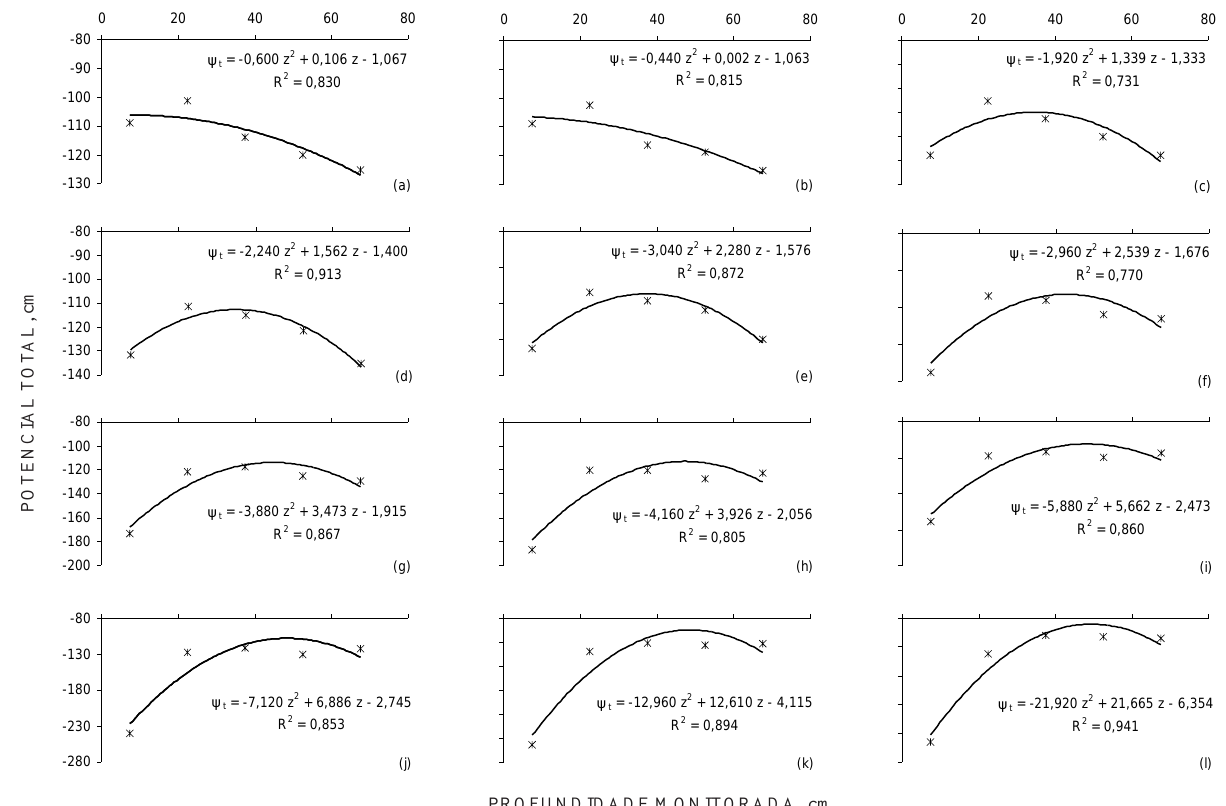
2. Potencial total ( yyyyy ) em função da profundidade ( z ) após 0 h (a), 17,9 h (b), 47,7 h (c), 65,1 h (d), t 88,5 h (e), 114,4 h (f), 137,8 h (g), 163,8 h (h), 186,8 h (i), 211,5 h (j), 282,6 h (k), 401,4 h (l), junto com a curva polinomial de 2 o . grau (Equação 4)